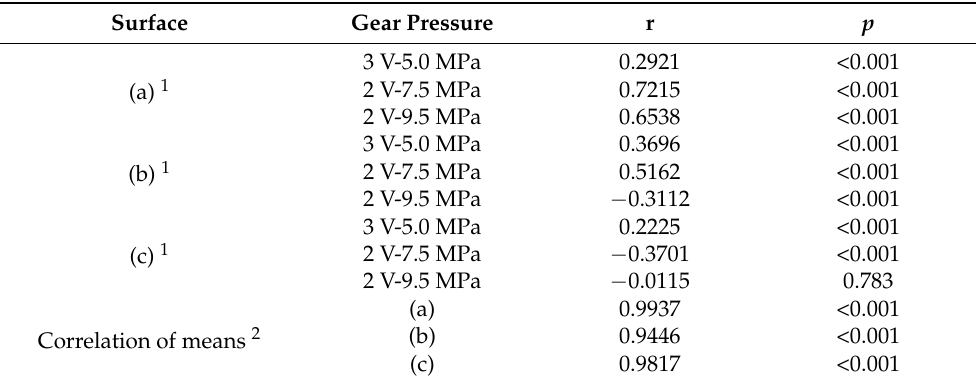
Table 6. Results of the Pearson’s tests carried out to assess the linear correlation between the force of ← F tra , and the vertical force at the tow-hook, traction, correlation